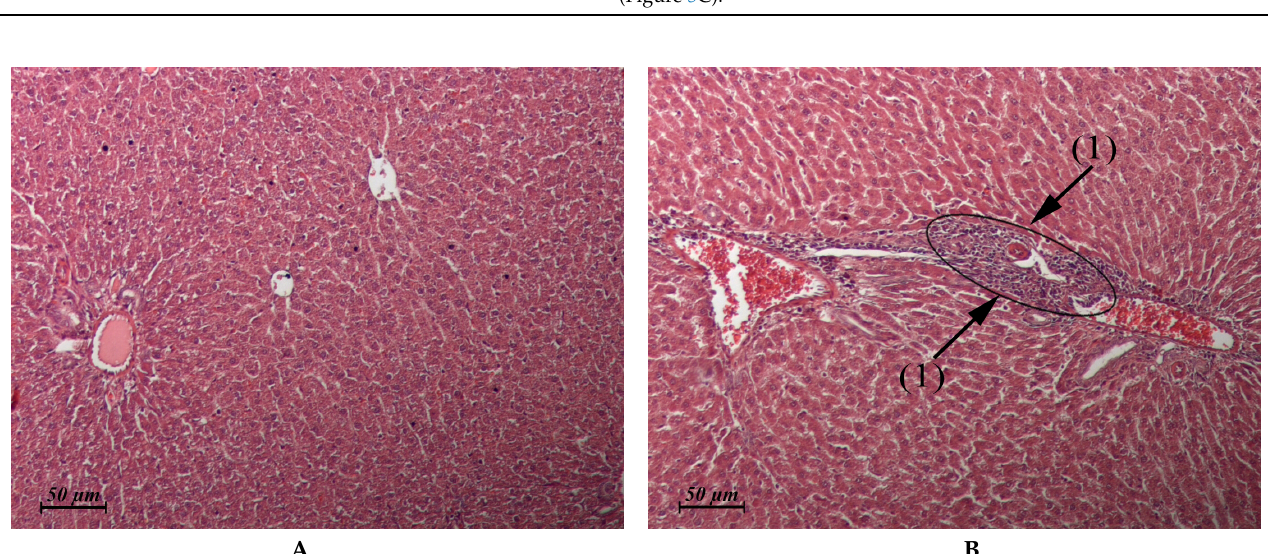
Figure 2. ( A , B ) Rat liver. ( A ) Untreated control. ( B ) Flavancin, 15 × 10 mg/kg/day, 1 day post- treatment. Micronecrotic focus in the vicinity of the triad (1) ×